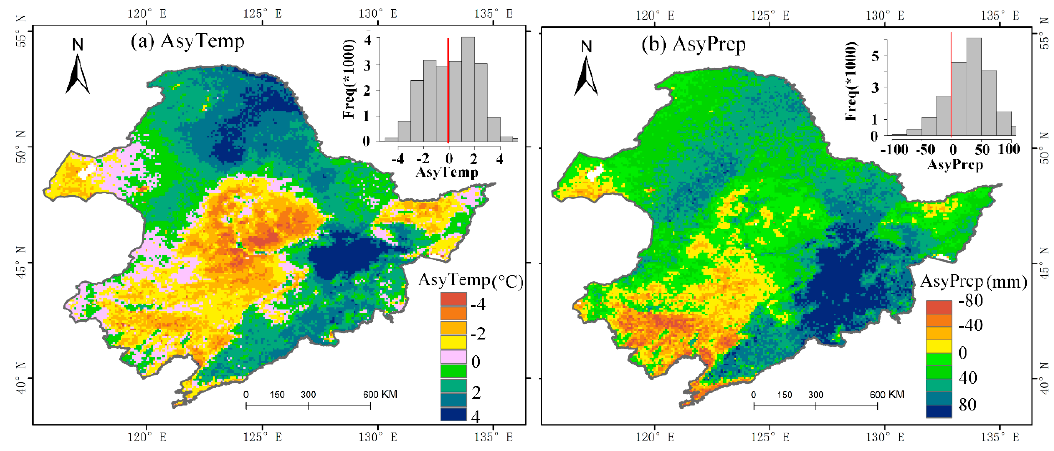
Figure 10. Maps of asymmetry for temperature and precipitation (1982–2015 multi-years average).